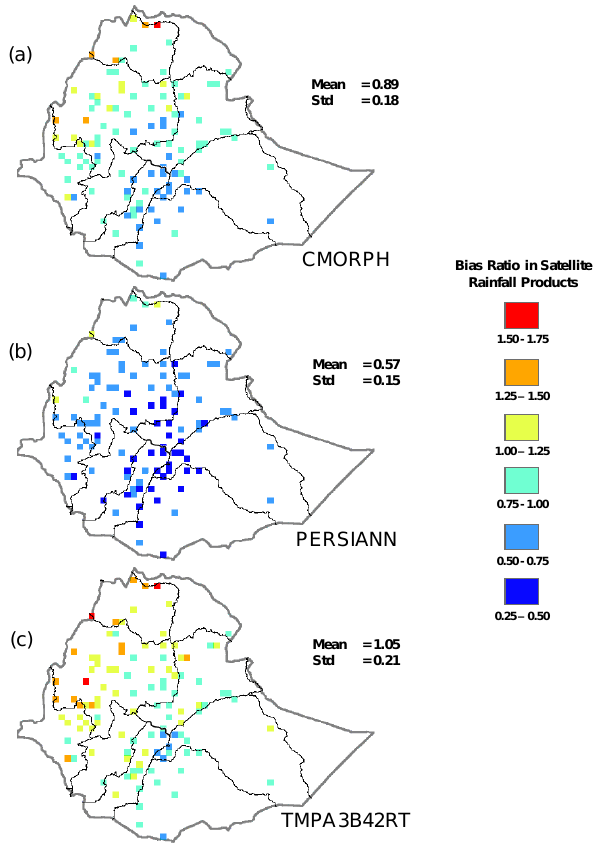
Fig. 4. Precipitation bias ratio in satellite rainfall products, 5yr average